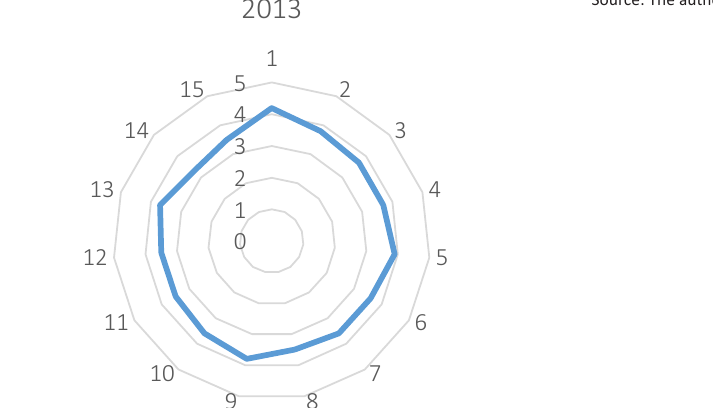
Figure 2. Radial chart of changes in CSR objectives (2013)